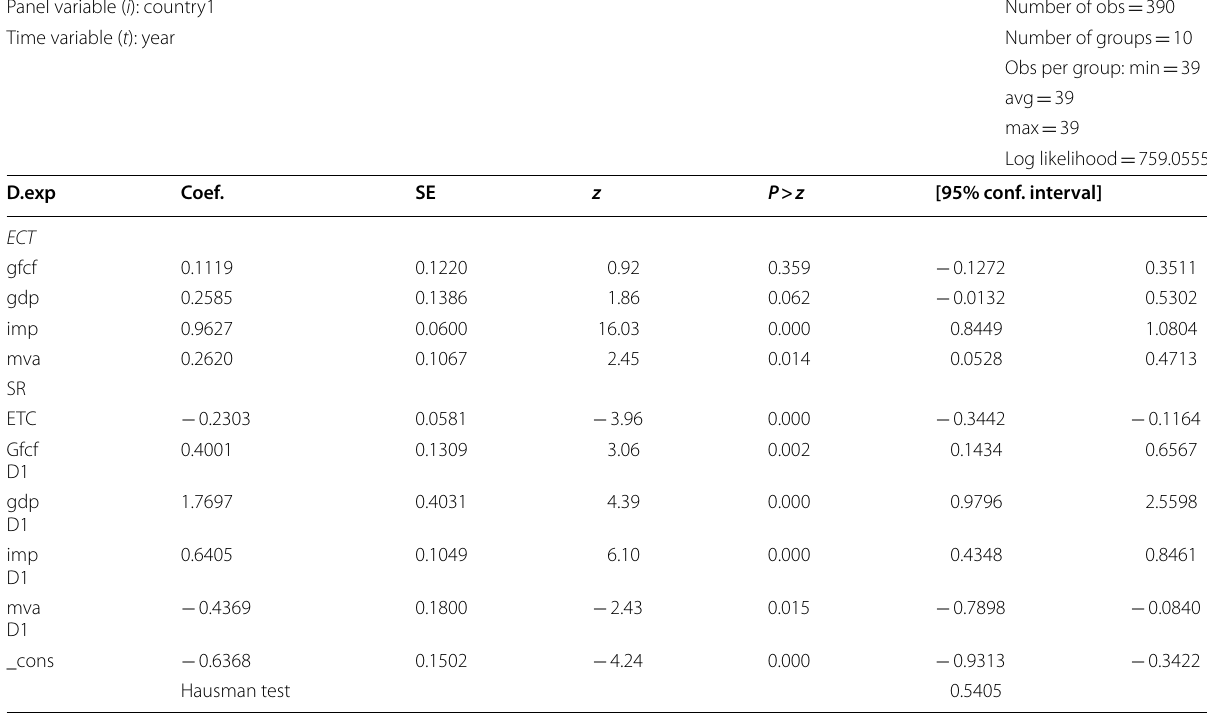
Table 2 Result of pooled mean group regression. Source : Computed from secondary data Panel variable ( i ):